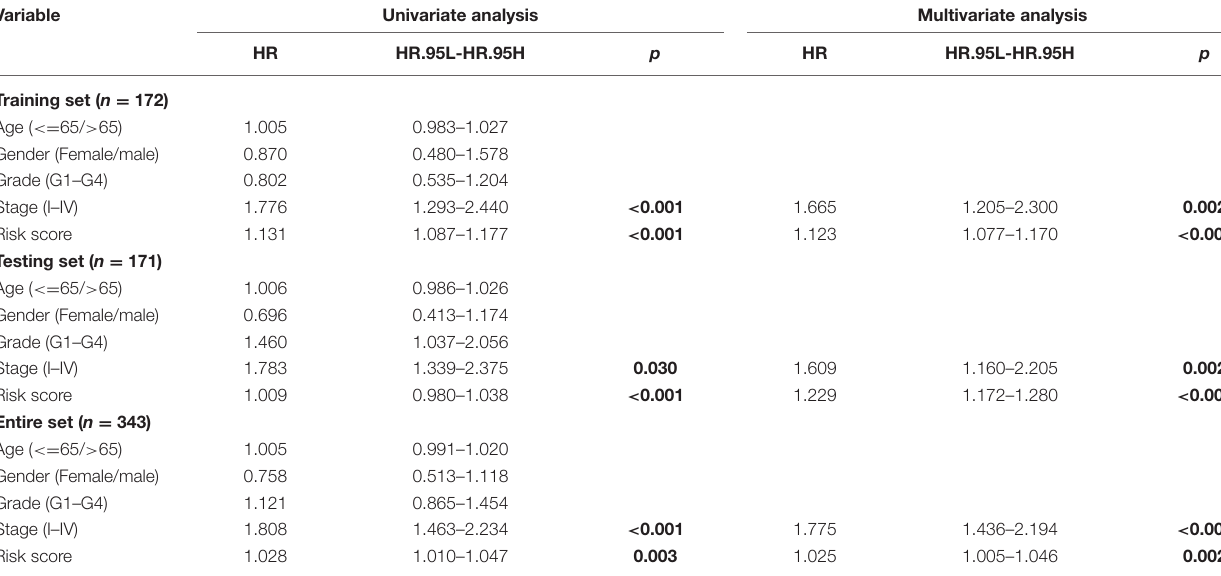
TABLE 3 | The univariate and multivariate Cox regression analyses in the training, testing, and entire groups.